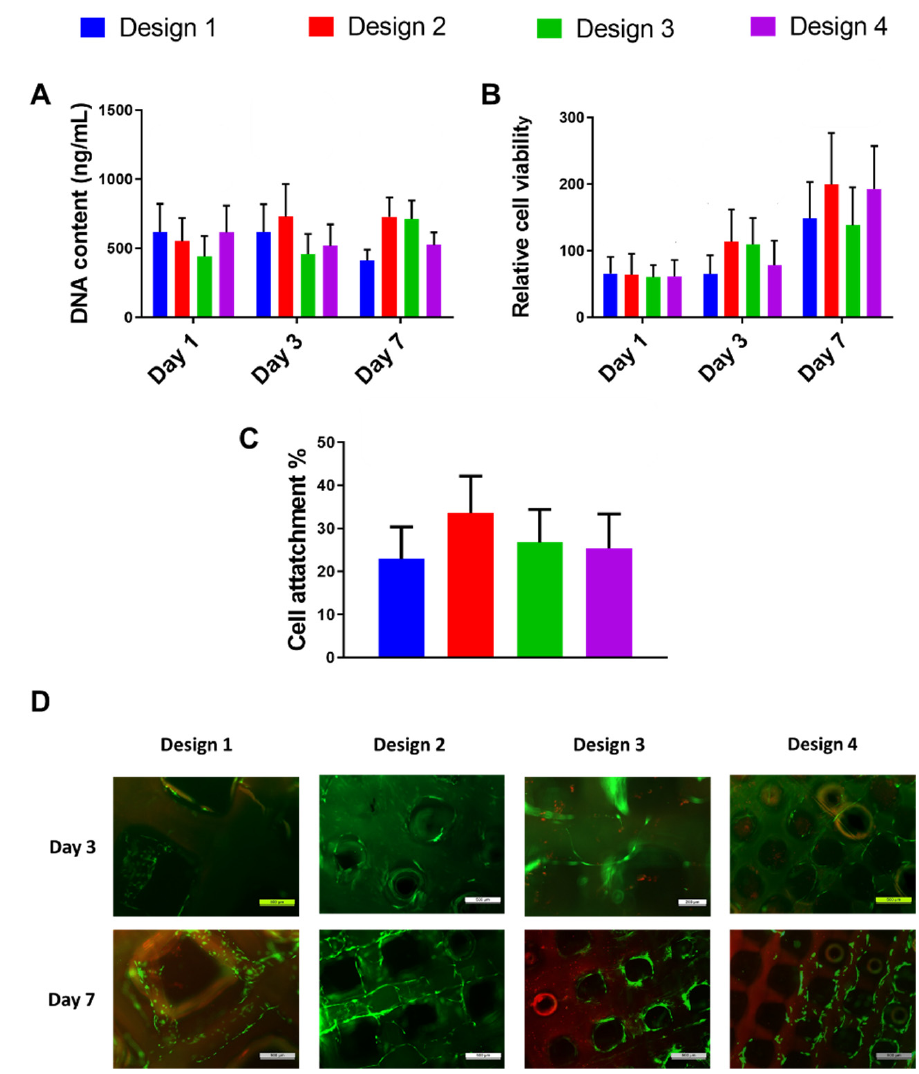
Figure 7. Effect of GelMA scaffold porous architecture on human dermal fibroblast DNA content ( A ), relative cell viability ( B ), attachment ( C ) and live/dead cell assay ( D ). Live cells are stained in green, and dead cells are stained red. No statistical difference was found between groups.